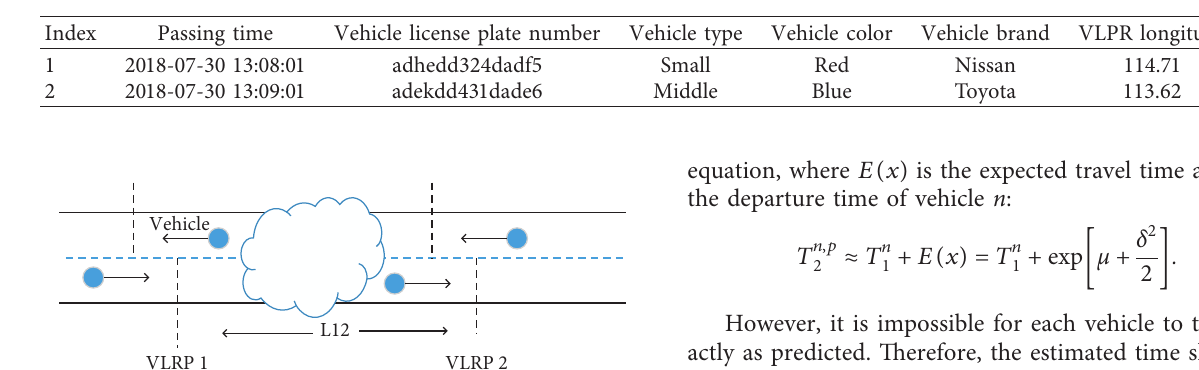
Table 2: VLPR data.